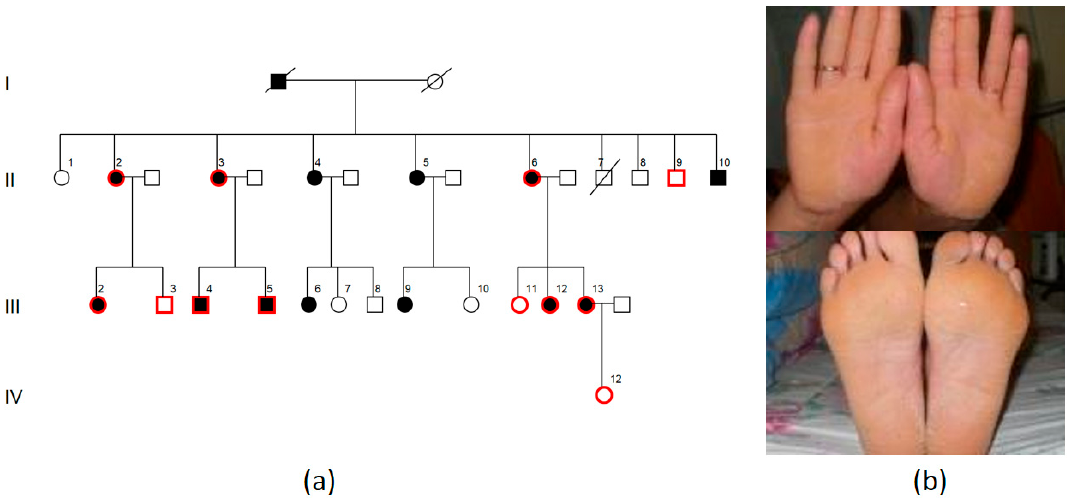
Figure 3. PPK3 pedigree: black—affected family members, white—healthy family members, I–IV—generations, 1–13—number of the person in the generation, red contour—examined and genotyped family members ( a ). PPK symptoms in patients: soft yellow diffuse palmoplantar keratoderma, keratolysis without a clear demarcation line on the borders of affected zones ( b ).